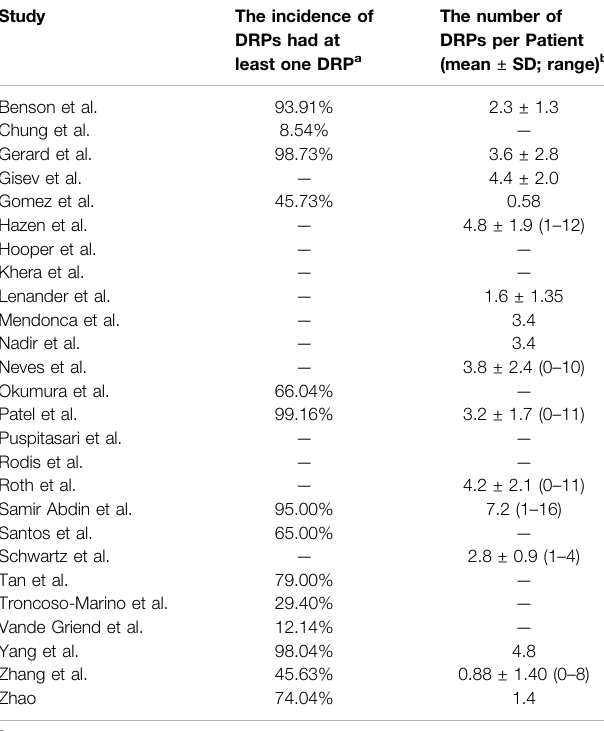
TABLE 3 | The incidence of DRPs and the mean number of DRPs per patient of included